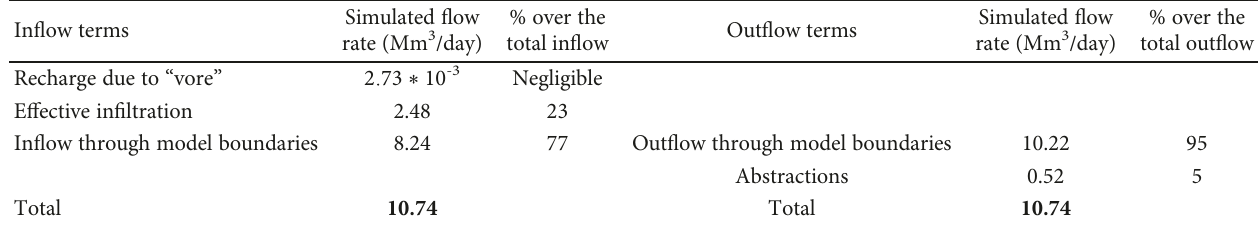
Table 3: Simulated water